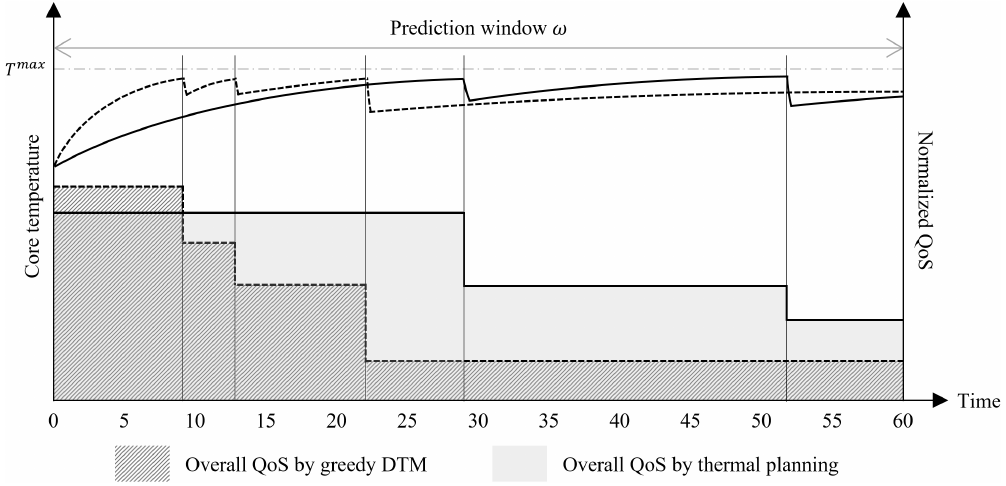
Figure 11. Transient QoS gain of our thermal planning compared with the greedy DTM.